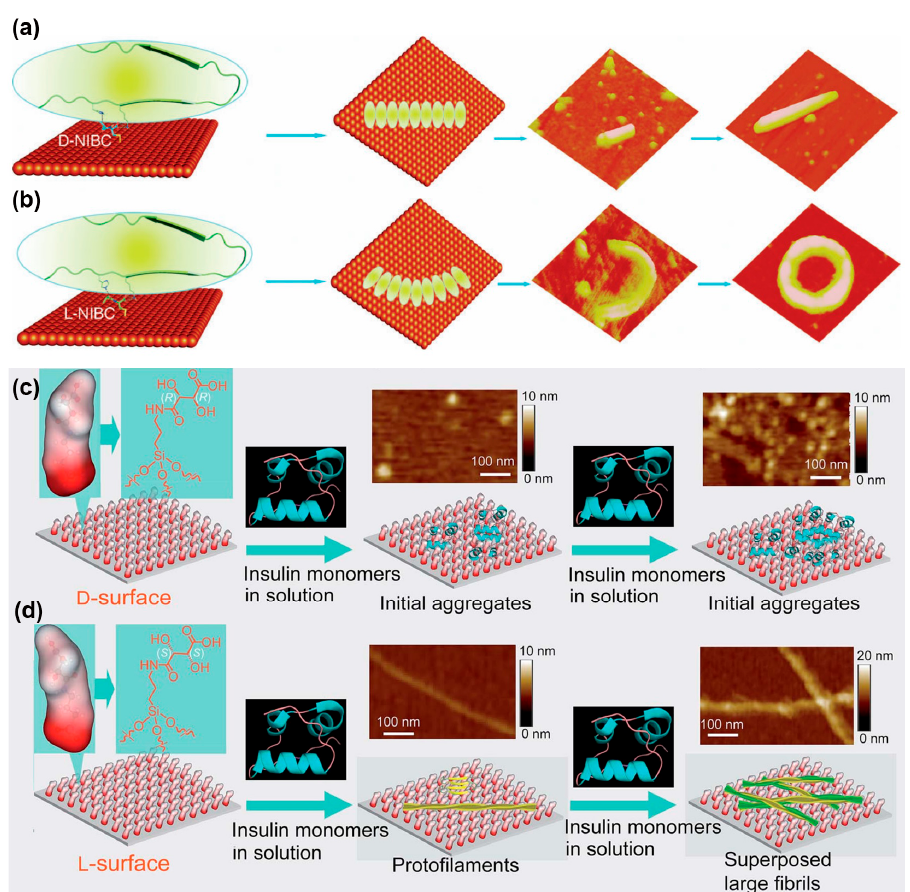
Figure 7. The different possible alignment modes of the β -hairpin that are guided by D - ( a ) or L - ( b ) N -isobutyryl cysteine (NIBC)-modified surfaces through stereoselective recognition enhanced by electrostatic interactions. A β (1–40) peptides at an ultralow concentration (1 μ M) have a tendency to form ring-like aggregates on the L -NIBC-modified surface and rod-like aggregates on the D -NIBC-modified gold substrates [100]. Schematic illustration of the different aggregation behaviors of insulin at the D - ( c ) and L - ( d ) tartaric acid-modified surfaces. Insulin at a high concentration of 10 μ g·mL − 1 tends to form unbranched long fibrils on the L -surface, whereas the D -surface was only covered with a monolayer of initial aggregates and no fibril-like aggregates were found [102]. ( a – d ) Adapted with permission. ( a , b ) Copyright 2014, Wiley Online Library. ( c , d ) Copyright 2014, Royal Society of Chemistry (RSC).